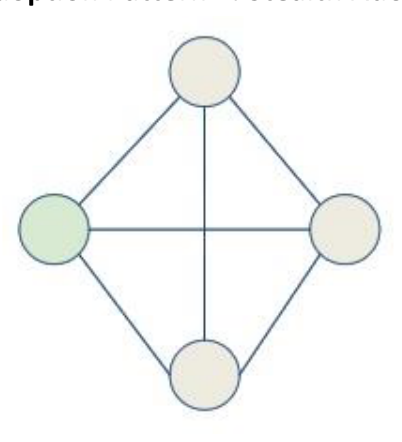
Figure 4. Visual representation of a stealth